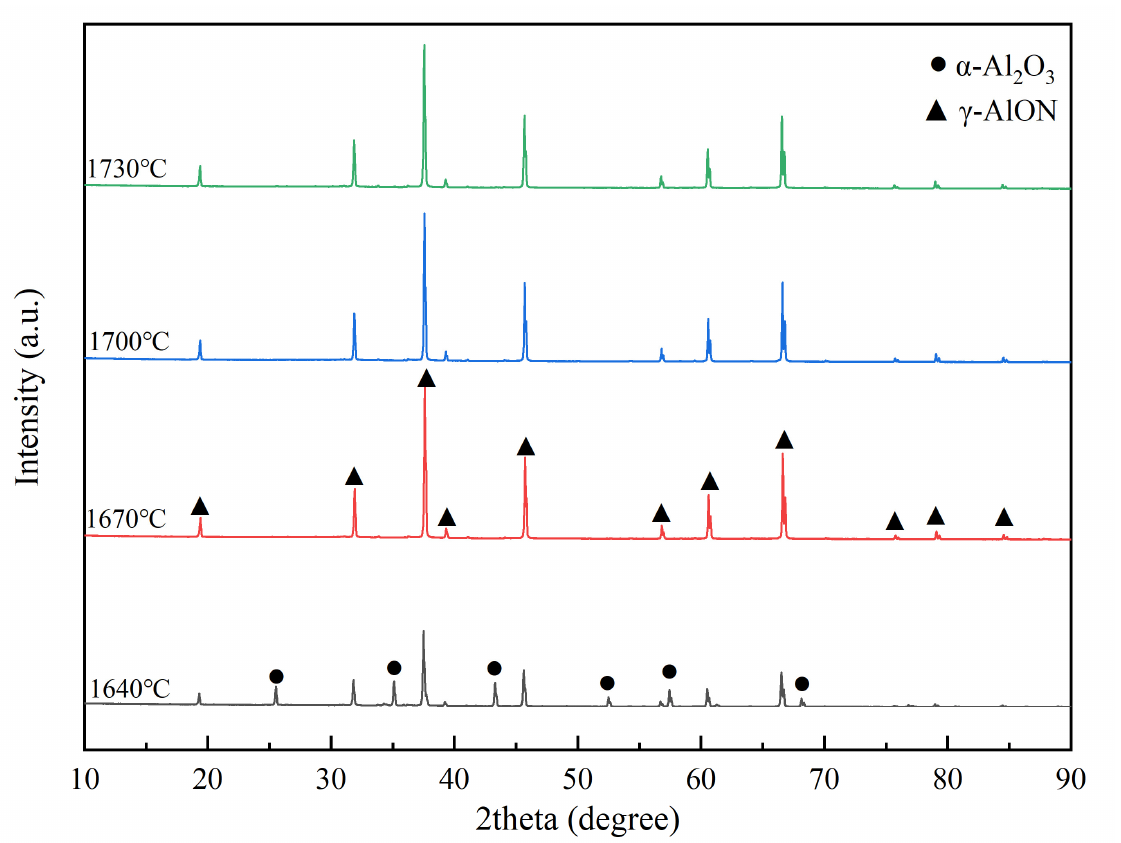
Figure 5. TG–DSC curves of the Al 2 O 3 /C mixed powder with different contents of dispersants in nitrogen: ( a ) 0 wt%; ( b ) 5 wt%.